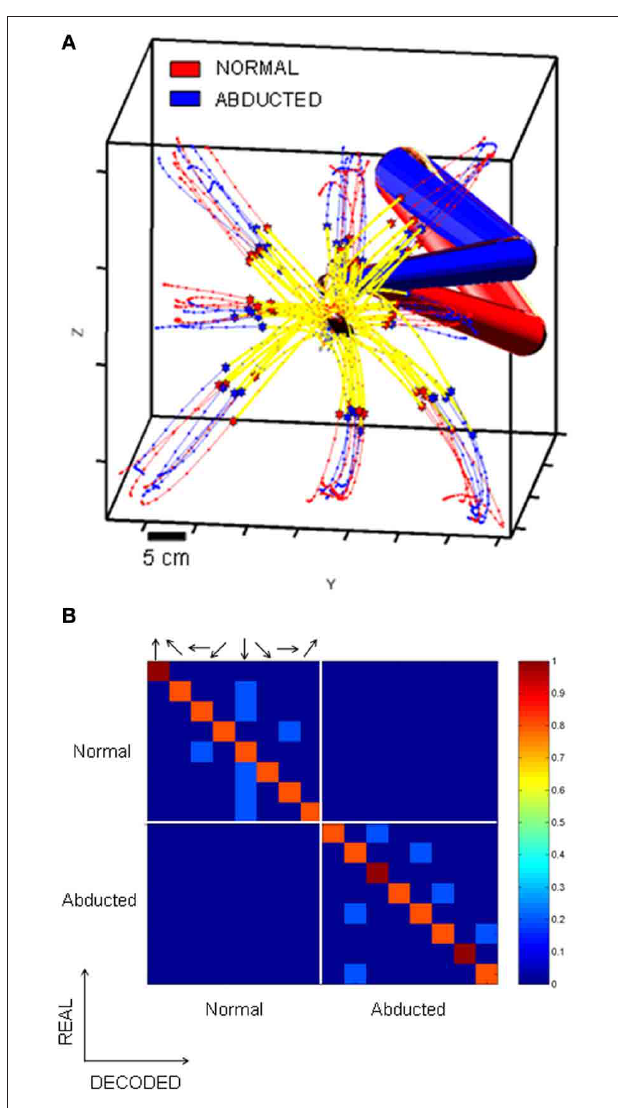
FIGURE 10 | Decoding analysis of movements with similar endpoint kinematics but different joint kinematics. The confusion matrices show the percentage of trials accurately decoded. Arrows indicate the direction of the target relative to the starting position of the hand. (A) Endpoint kinematics for sets of movements involving different initial arm postures and therefore different joint kinematics. Endpoint kinematics were statistically indistinguishable. (B) Confusion matrices based on the spiking activity of 31 MIP neurons tested with both normal and abducted initial arm postures. Data from trials involving different joint kinematics were not confused by the decoder (off diagonal matrices), implying that MIP activity can distinguish among movements involving different trajectories in joint